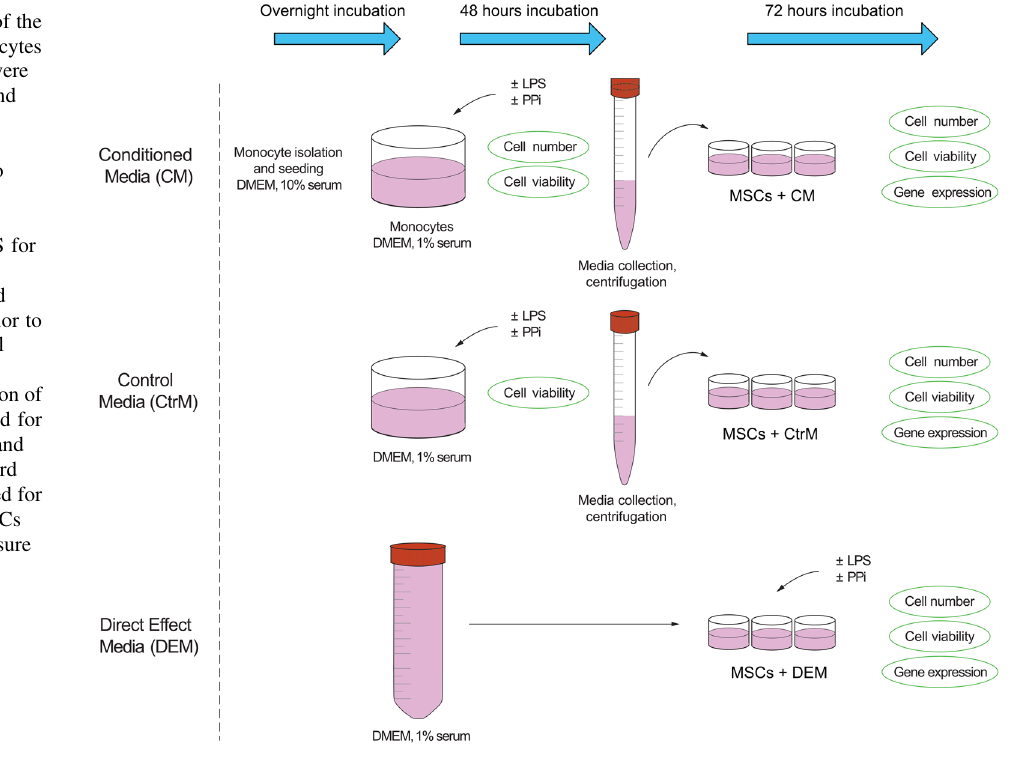
Fig. 1 Schematic drawing of the experimental outline. Monocytes isolated from buffy coats were seeded into 6-well plates and incubated overnight. The medium was changed, and monocytes were exposed to varying concentrations of pyrophosphate (PPi) in the presence or absence of LPS for 48 h. The medium was withdrawn, centrifuged, and added to MSCs for 72 h prior to analysis. In parallel, control media (CtrM) – without monocytes – with the addition of PPi and LPS were incubated for 48 h before centrifugation and exposure to MSCs. In a third track, medium was incubated for 48 h before addition to MSCs with additional direct exposure of MSCs to PPi and LPS, referred to as direct effect media